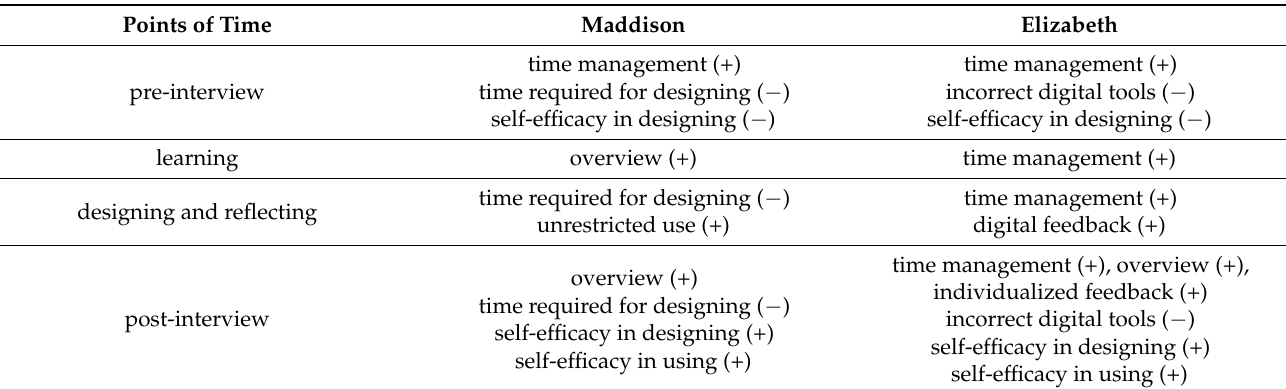
Table 2. Maddison’s and Elizabeth’s beliefs about burden and relief created for a teacher by using digital tools such as STACK during the